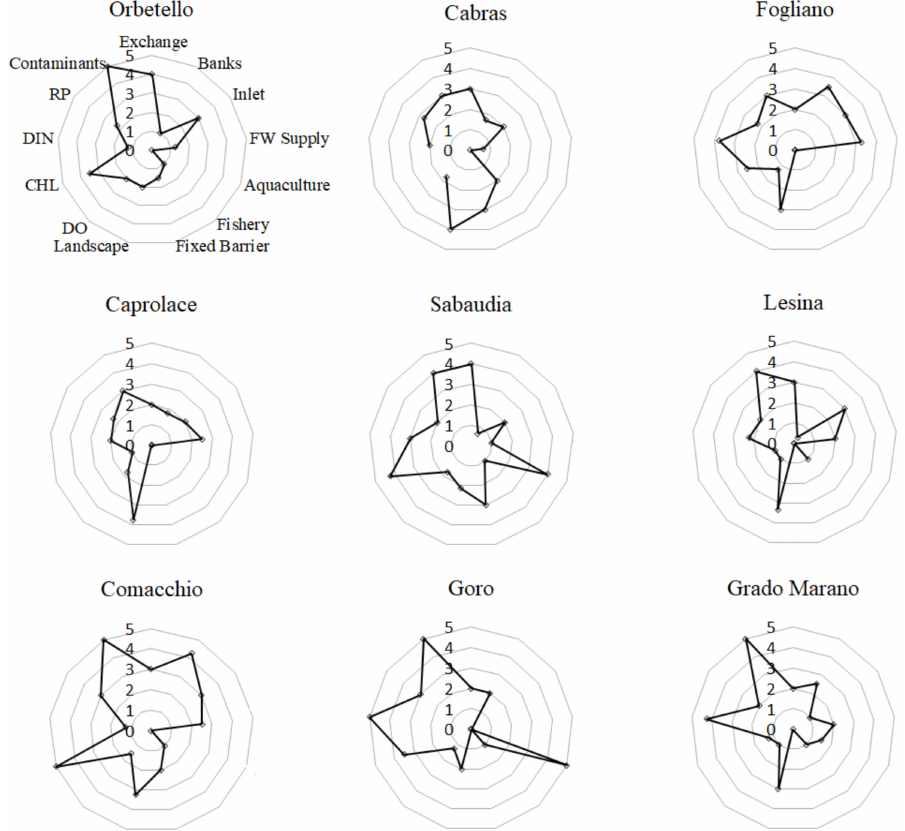
Figure 2. Scores of the anthropogenic pressure indicators for the nine coastal lagoons under study. Scores range between 0 (low pressure) and 5 (high pressure). Vectors represent: Water renewal time (Exchange), Percentage of natural banks (Banks), Status and efficiency of tidal inlets (Inlet), Surface freshwater tributaries (FW Supply), Mussel farming (Aquaculture), Fisheries activities (Fishery), Closed months per year by barriers (Fixed barrier), Percentage of anthropogenically affected land (Landscape), Dissolved Oxygen (DO), Chlorophyll- a (CHL), Dissolved Inorganic Nitrogen (DIN), Reactive Phosphorus (RP), and